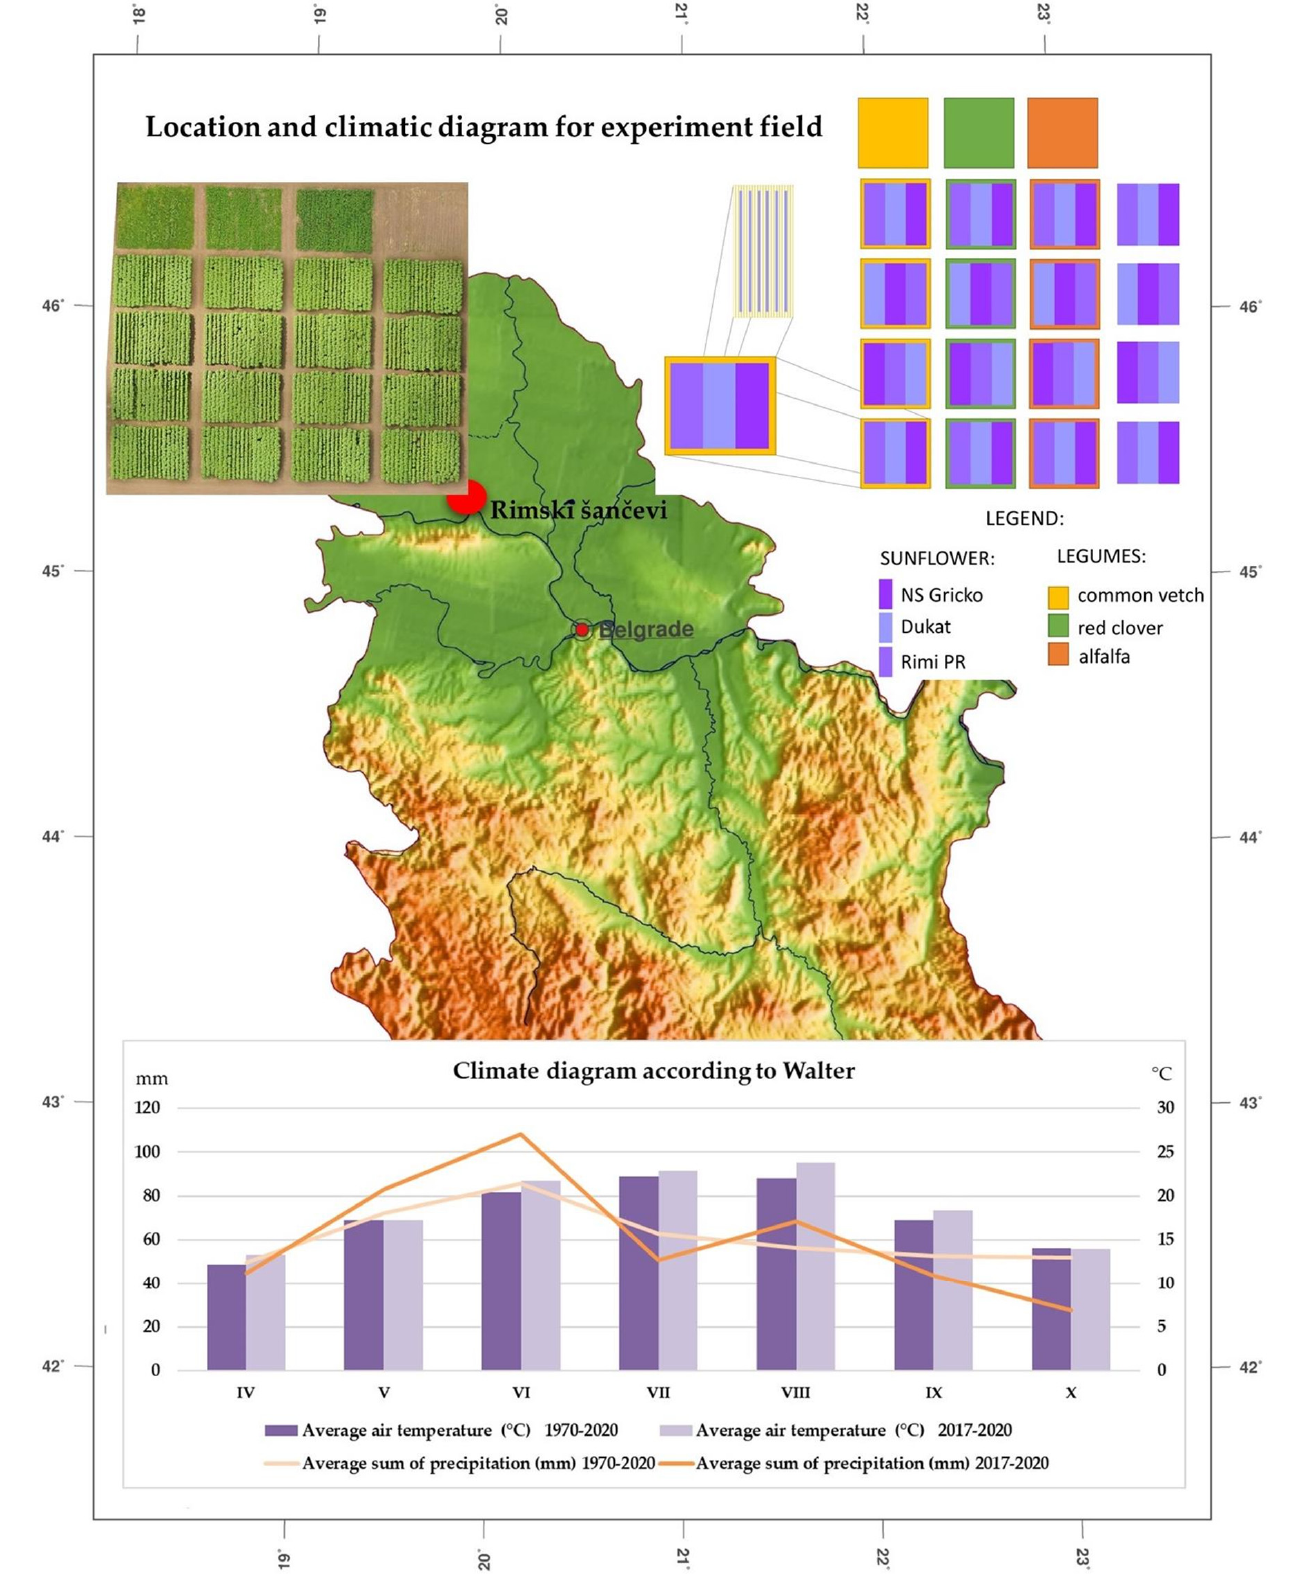
Figure 2. Location of the trial and climatic conditions for the study period with long-term